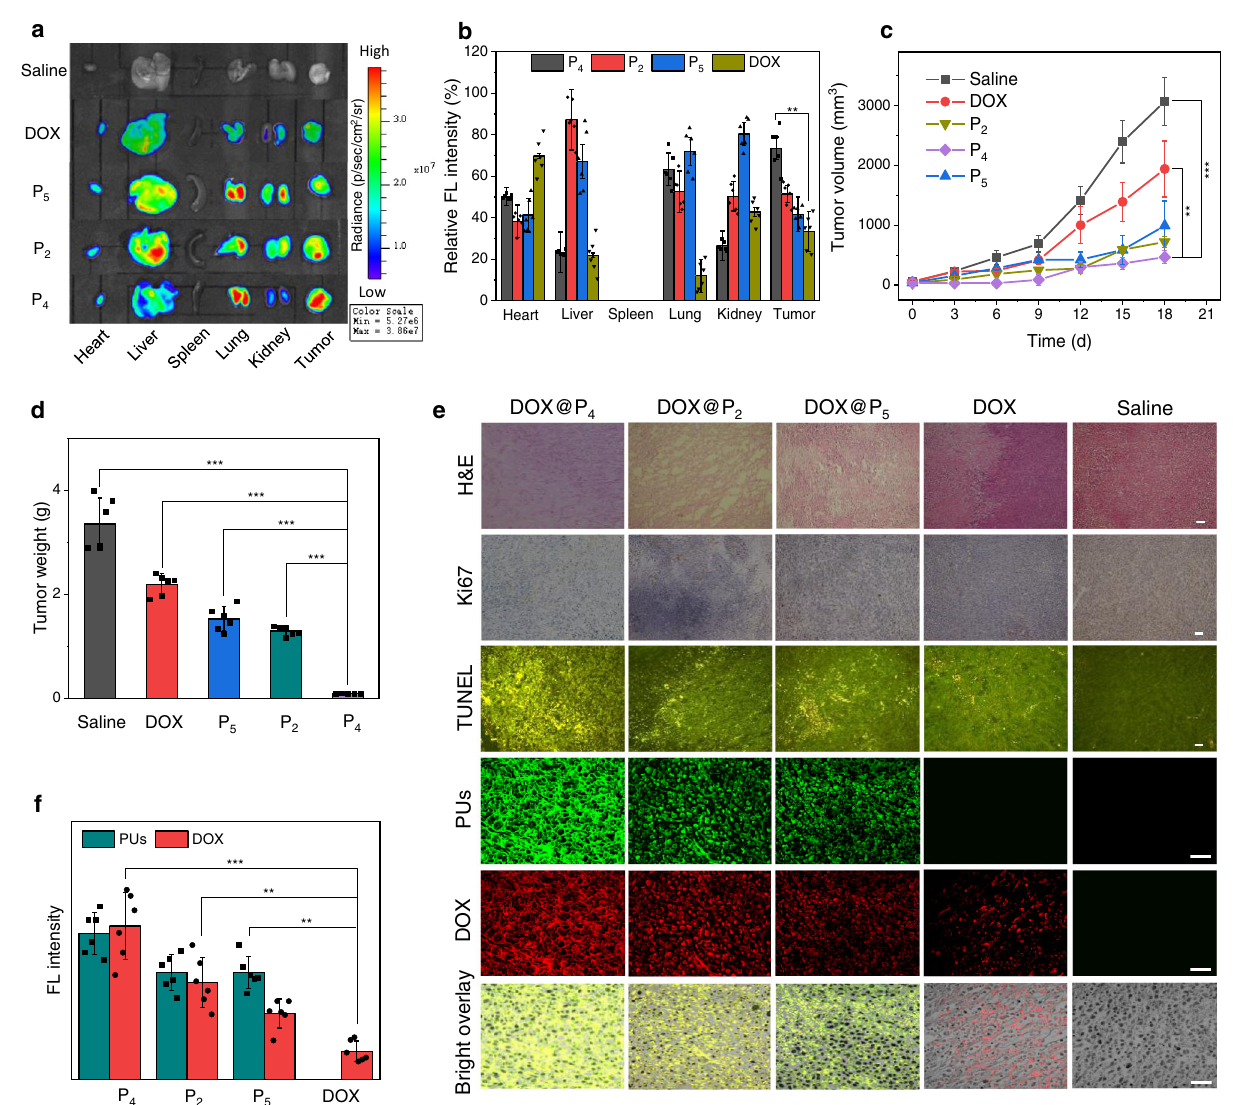
Fig.6|Invivobiodistributionandantitumoref fi cacy.a Fluorescenceimagesof major organs and tumors at 24h after the intravenous administration of saline, free DOX or DOX-loaded PU assemblies ( λ ex =480nm, λ em =600nm). The experiments were repeated independently three times. b Semi-quantitative analysisof DOX fl uorescence in major organs and tumors. Dataare presented as the mean±SD ( n = 6 independent animals, ** p = 0.0061). c The growth curves of subcutaneous MCF-7 tumors after intravenous injection of saline, free DOX,